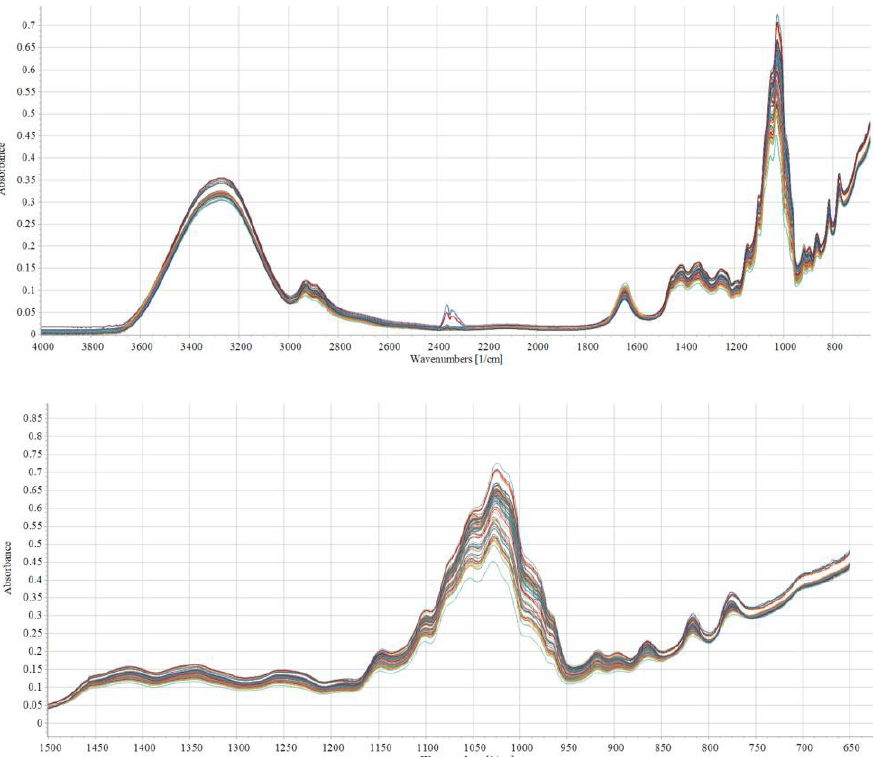
Figure 2. The FTIR spectra of honey samples of different botanical origin: raspberry, mint, rape, sunflower, thyme, acacia and tilia honey. (Reprinted with permission from ref [29]).